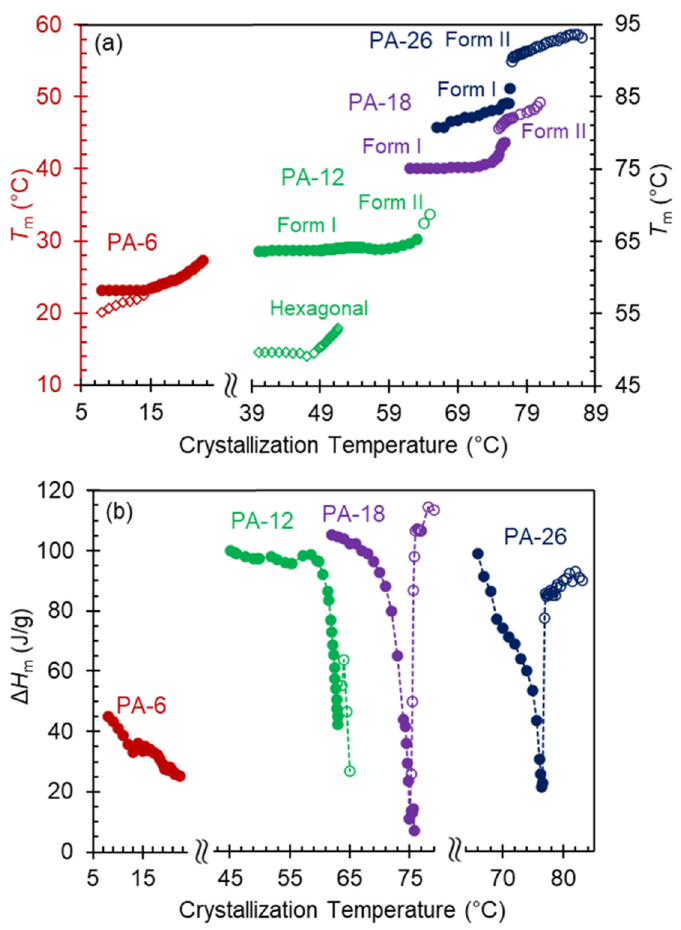
Figure 5. ( a ) Melting temperatures, and ( b ) heat of fusion after complete transformation as a function of crystallization temperature for PA-6 (red), PA-12 (green), PA-18 (purple), and PA-26 (dark blue). Filled circles correspond to Form II, open circles to Form I, and open diamonds to hexagonal crystals. Heat of fusion data are joined by dotted lines to emphasize the extremely low heat of fusion at the transition between Form I and Form II.